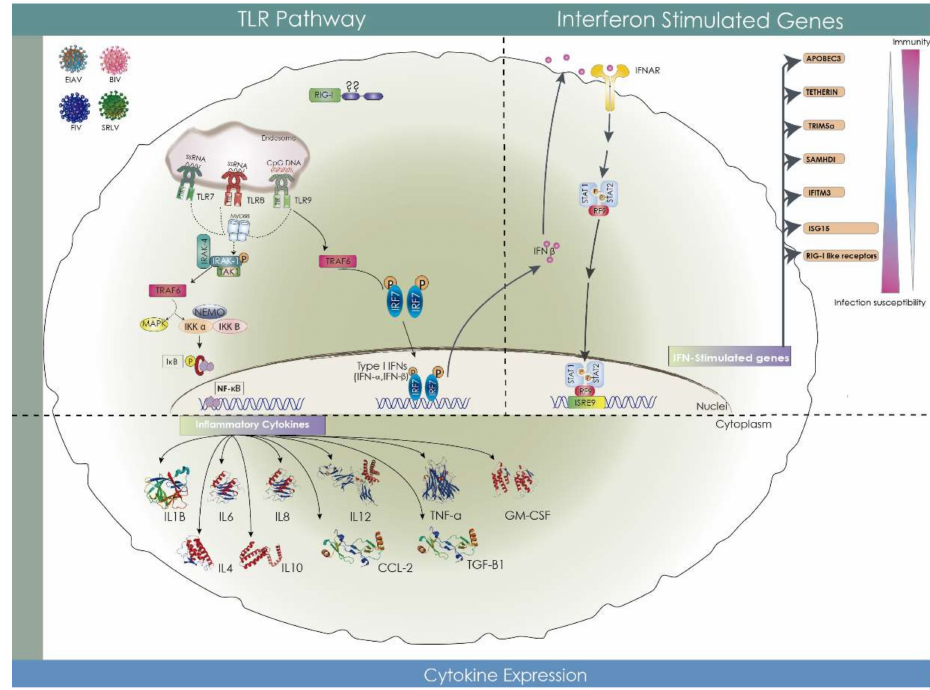
Figure 4. Animal lentiviruses innate immune sensing. Toll-like receptors (TLRs) 7, 8, and 9 can sense virus-derived nucleic acids and induce a signaling cascade involving IRAK-1 that results in the expression of inflammatory cytokines and type I-IFN, such as interferon alpha (IFN- α ) and beta (IFN- β ). Receptor for IFN (IFNAR) engages type I IFN molecules, inducing the expression of many antiviral proteins known as IFN-stimulated genes, among which, restriction factors are